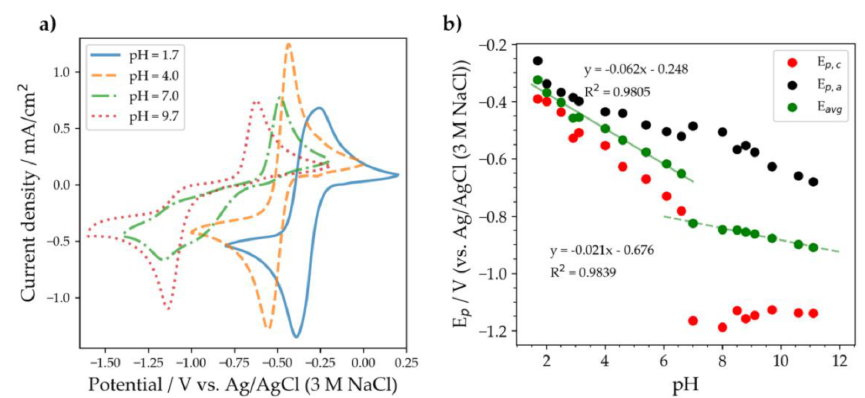
Figure 8. ( a ) Cyclic voltammetry of a 5 mM DSMeQUI 20 solution in a Britton–Robinson universal buffer solution with added KCl at various pHs. The voltammograms were recorded at a scan rate of 100 mV/s using a 3 mm diameter glassy carbon disk electrode. ( b ) The reduction (red) and oxidation (black) peak potential and average peak potential (green) as a function of